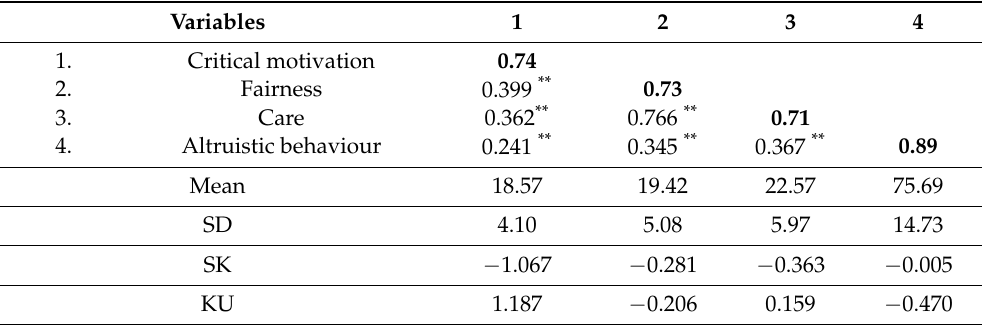
Table 2. Descriptive Statistics, Reliability Estimates and Correlations Between Variables.